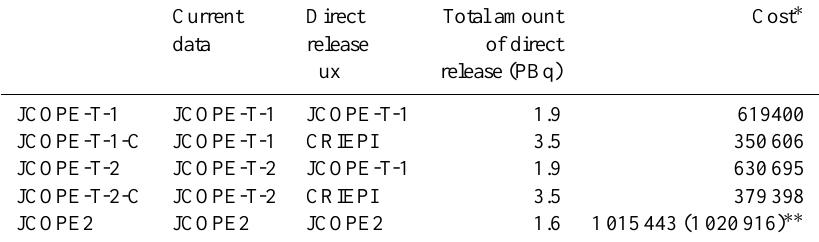
Table 2. Description of first-guess